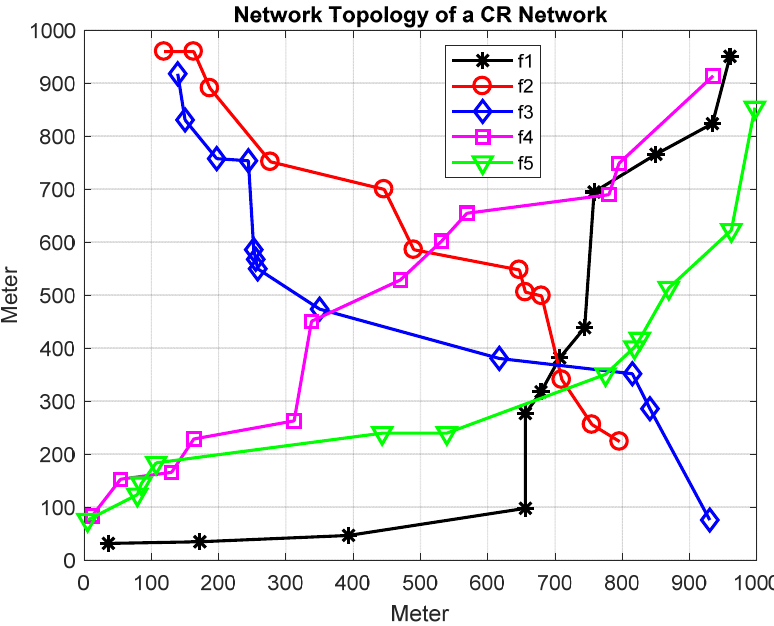
Figure 3. CR-IoT Network Topology.